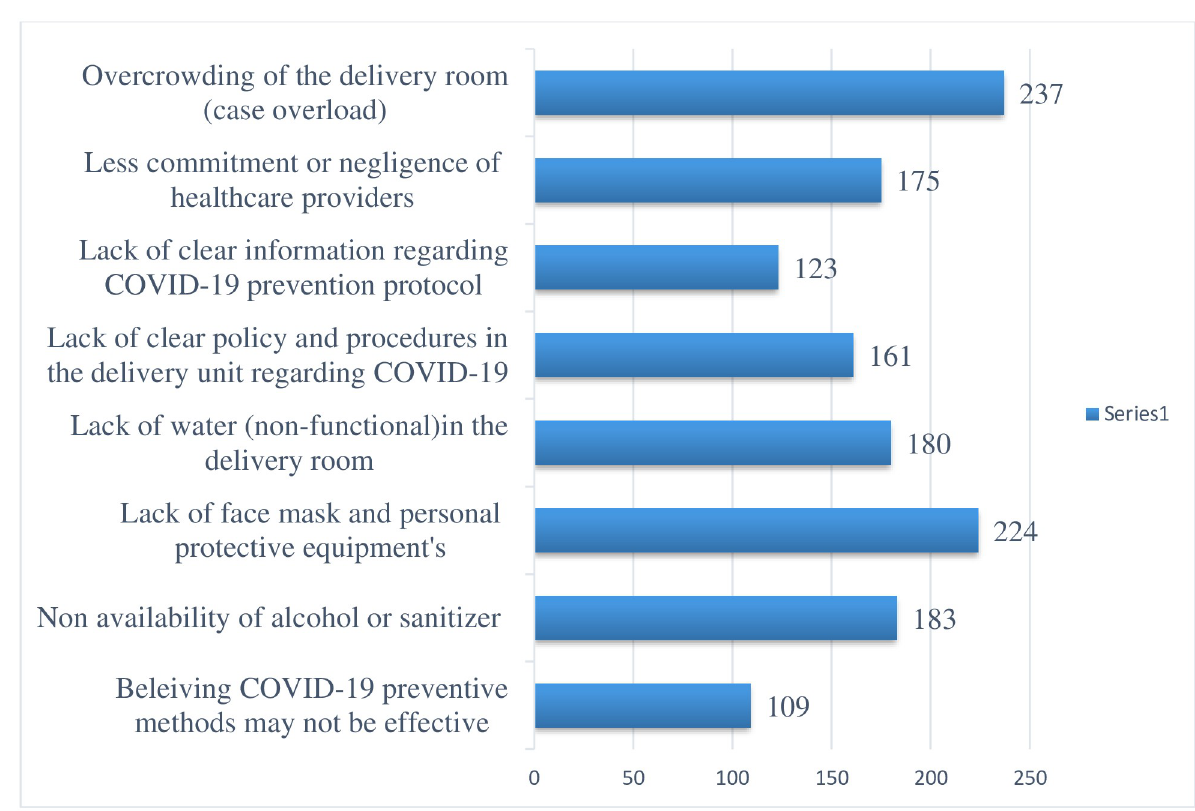
Fig 1. Barriers for the poor adherence level of healthcare providers to the COVID-19 preventive measures during intrapartum care service provision in Gondar province Hospitals, northwest Ethiopia, 2021.